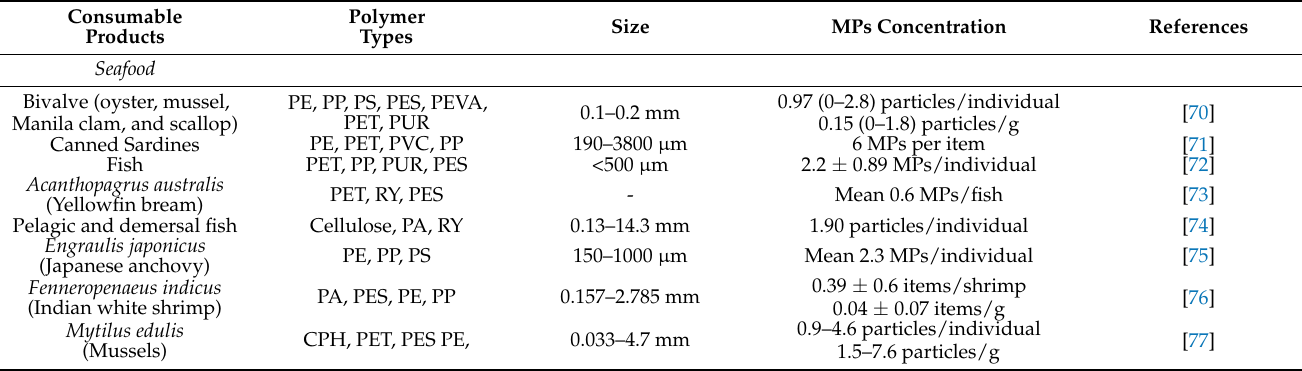
Table 3. Presence of MPs in food items and drinks consumed by